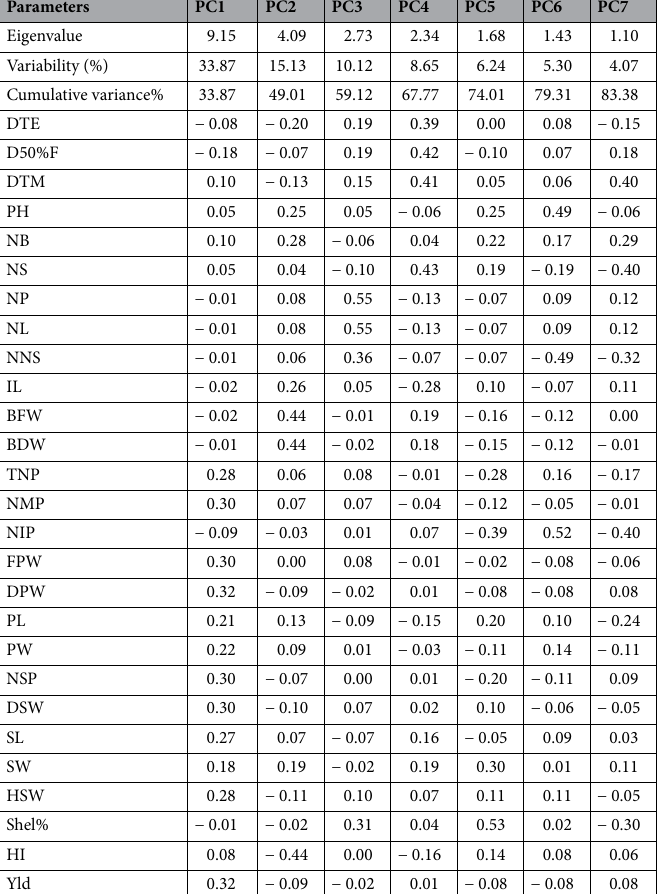
Table 10. Eigenvalues, variation percentage, and eigenvectors revealed by PCA analysis. PC Principal component, DTE Days to emergence (d), D50%F Days to 50% flowering (d), DTM Days to maturity (d), PH Plant height (cm), NB Number of branches per plant, NS Number of stems per plant, NP Number of petioles per plant, NL Number of leaves per plant, NNS No. of nodes per stem, IL Inter nodes length (cm),